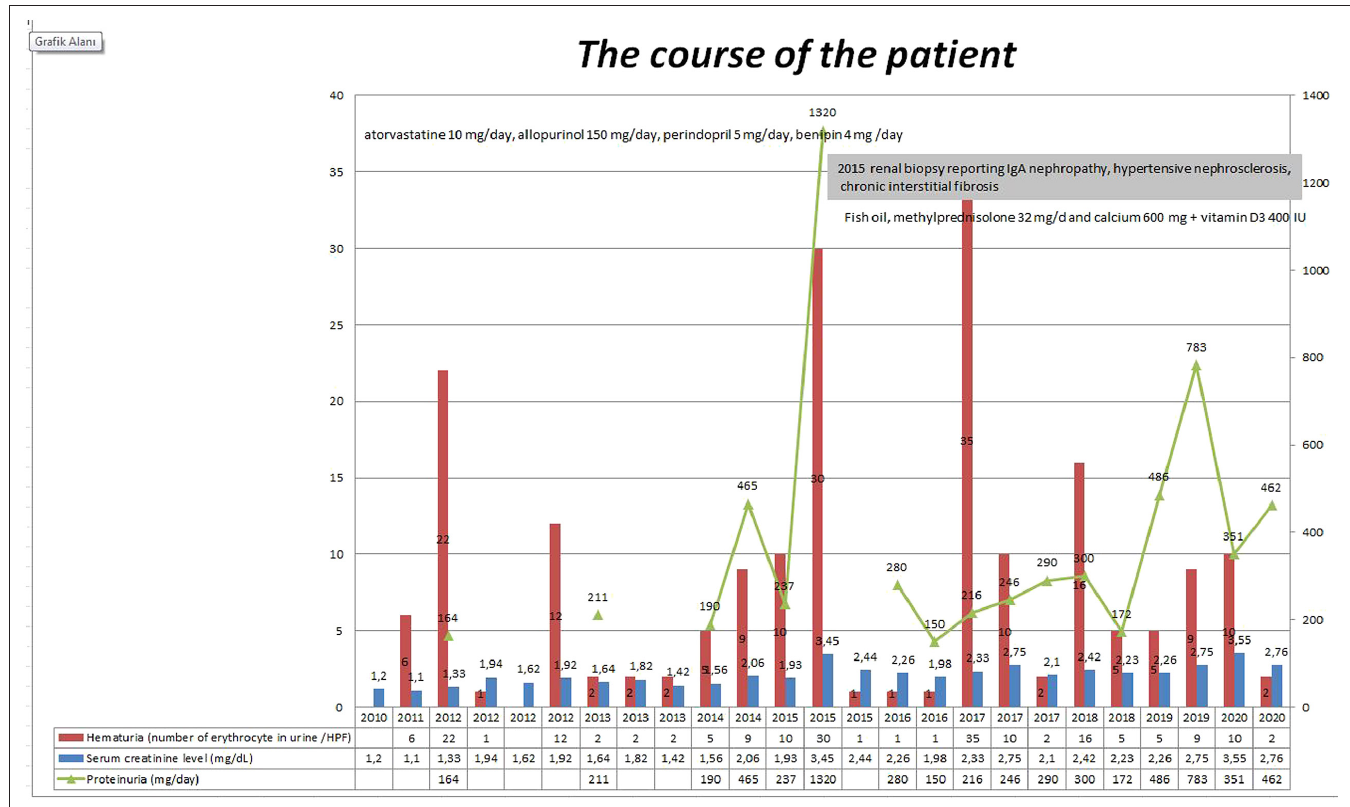
Figure 3. The course of the patient during 9 years of